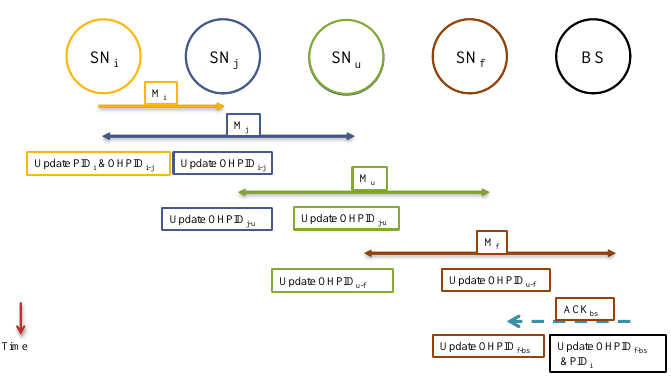
Figure 4. Using APID i for acknowledgement with no errors.